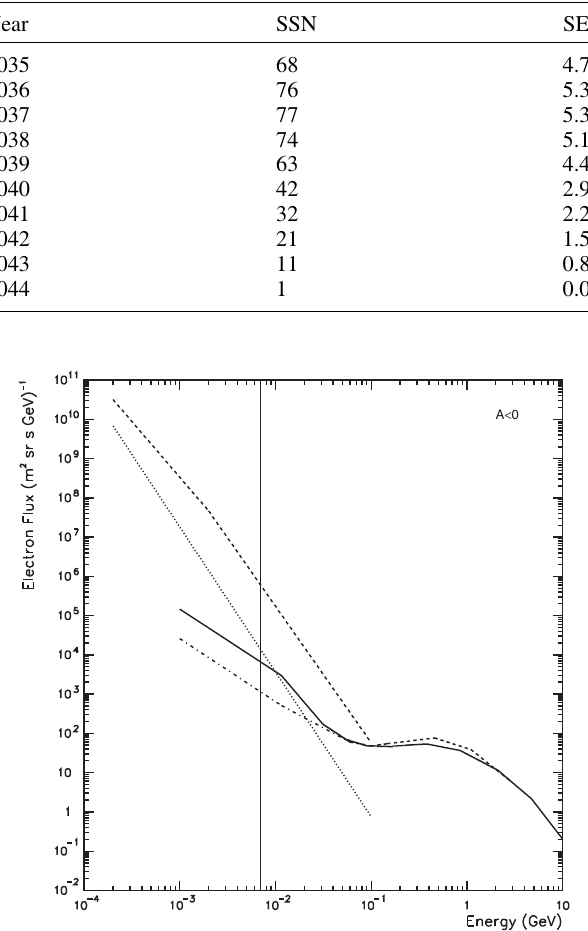
Figure 17. Solar electron fl uxes associated with impulsive (upper dashed line) and gradual (dotted line) SEP events (Grimani et al., 2009a). The continuous line, the dot-dashed line and the bottom dashed line, represent minimum and maximum interplanetary and galactic electron fl uxes observed during a negative polarity period ( A < 0) of the GSMF (when the solar magnetic fi eld lines enter the North pole of the Sun) during which the fl ux of negative particles is maximum with respect to periods of positive GSMF polarity and similar conditions of solar activity (Grimani et al., 2009a). The vertical continuous line indicates the maximum electron energy measured by the NGRM. It can be observed that below 7 MeV the solar electron fl ux is overcome by several orders of magnitude of the interplanetary and galactic components allowing for SEP event forecasting.